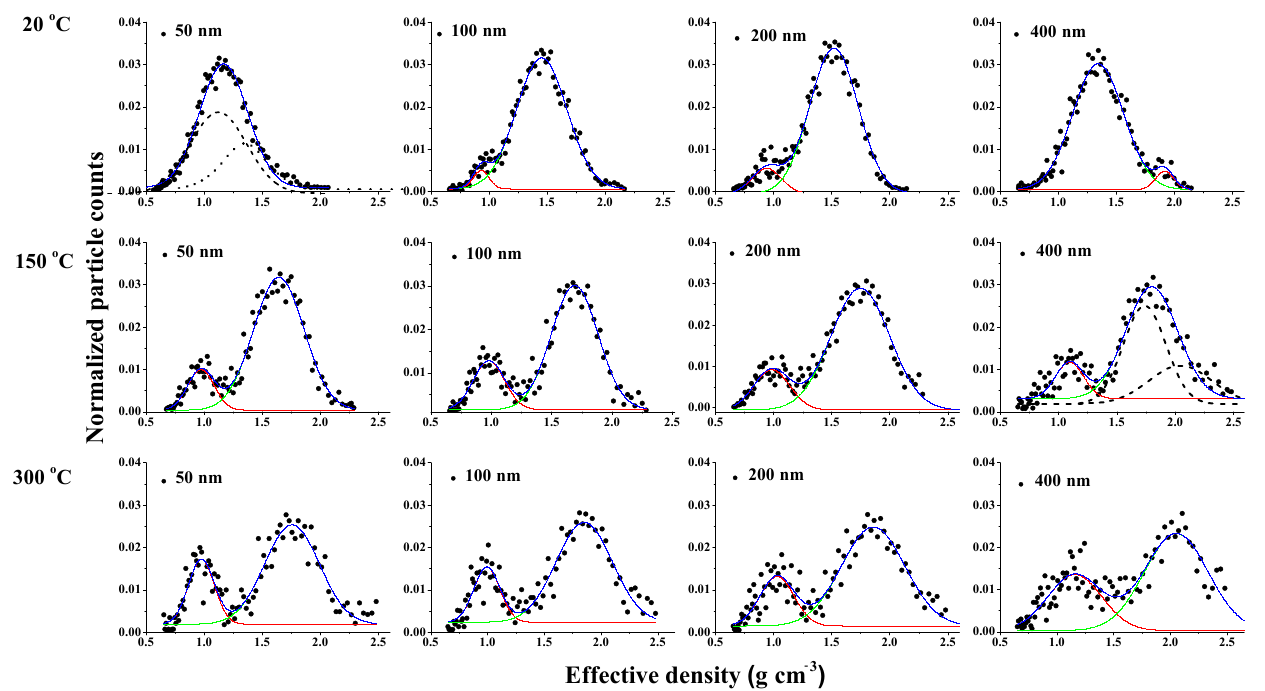
Figure 2. Average density distributions of 50, 100, 200, and 400nm particles selected by DMA at 20 ◦ C (room temperature), 150 ◦ C, and 300 ◦ C. A Gaussian model was applied in fitting each density scan (red and green lines). The black dashes indicate the application of the Gaussian assumption